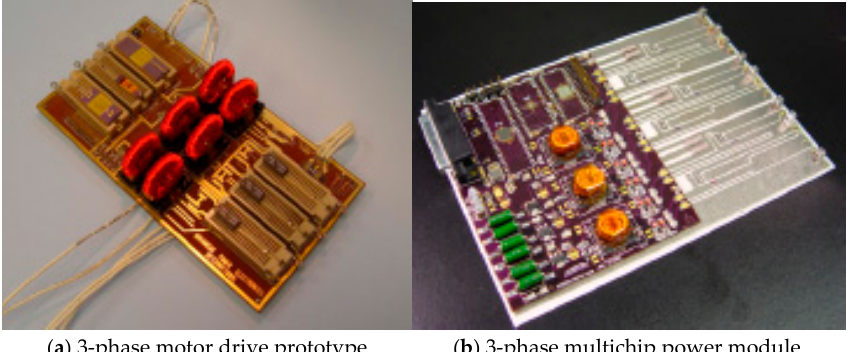
Electronics International. Micromachines 2019 , 10 , x FOR PEER REVIEW